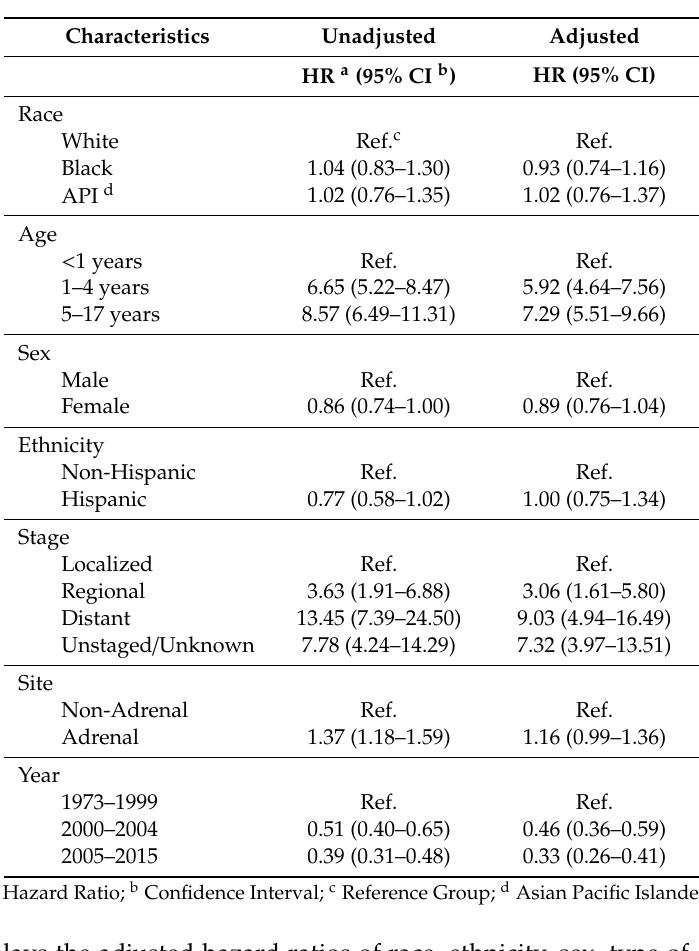
Table 2. Unadjusted and adjusted hazard ratios for 5-year cause-specific survival among patients in the SEER database diagnosed with neuroblastoma between 1973 and 2015.